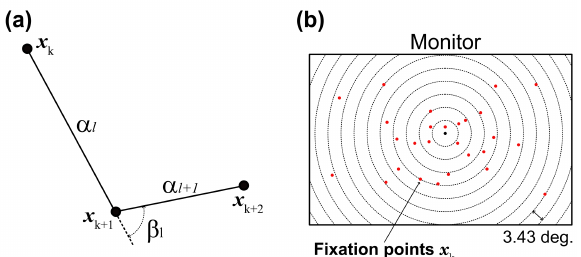
Figure-02. Eye-position analysis. (a) Gaze-shift angle ( 𝛽 computed from three adjacent fixation points ( 𝒙 and corresponding saccade amplitudes ( 𝛼 parameters were used for clustering gaze-shift patterns. (b) Gaze distribution was obtained by density of gaze fixations in each series of concentric circles. Radii of circles were set to 1/20 diagonal of the monitor (3.43 deg.) x N deg. (N =